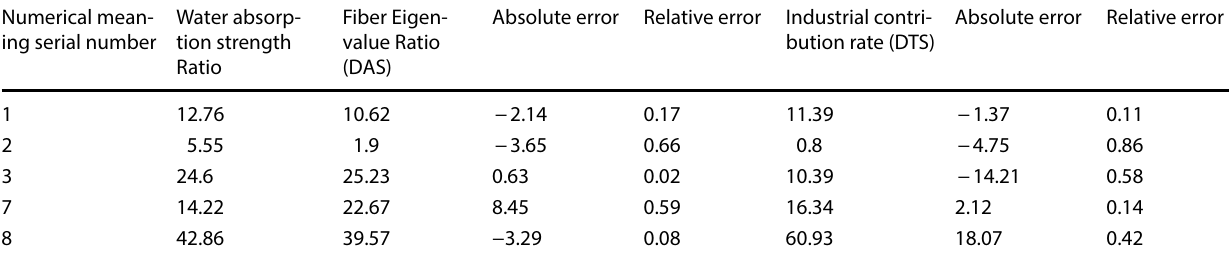
Table 5 Error analysis and comparison Numerical mean- ing serial number